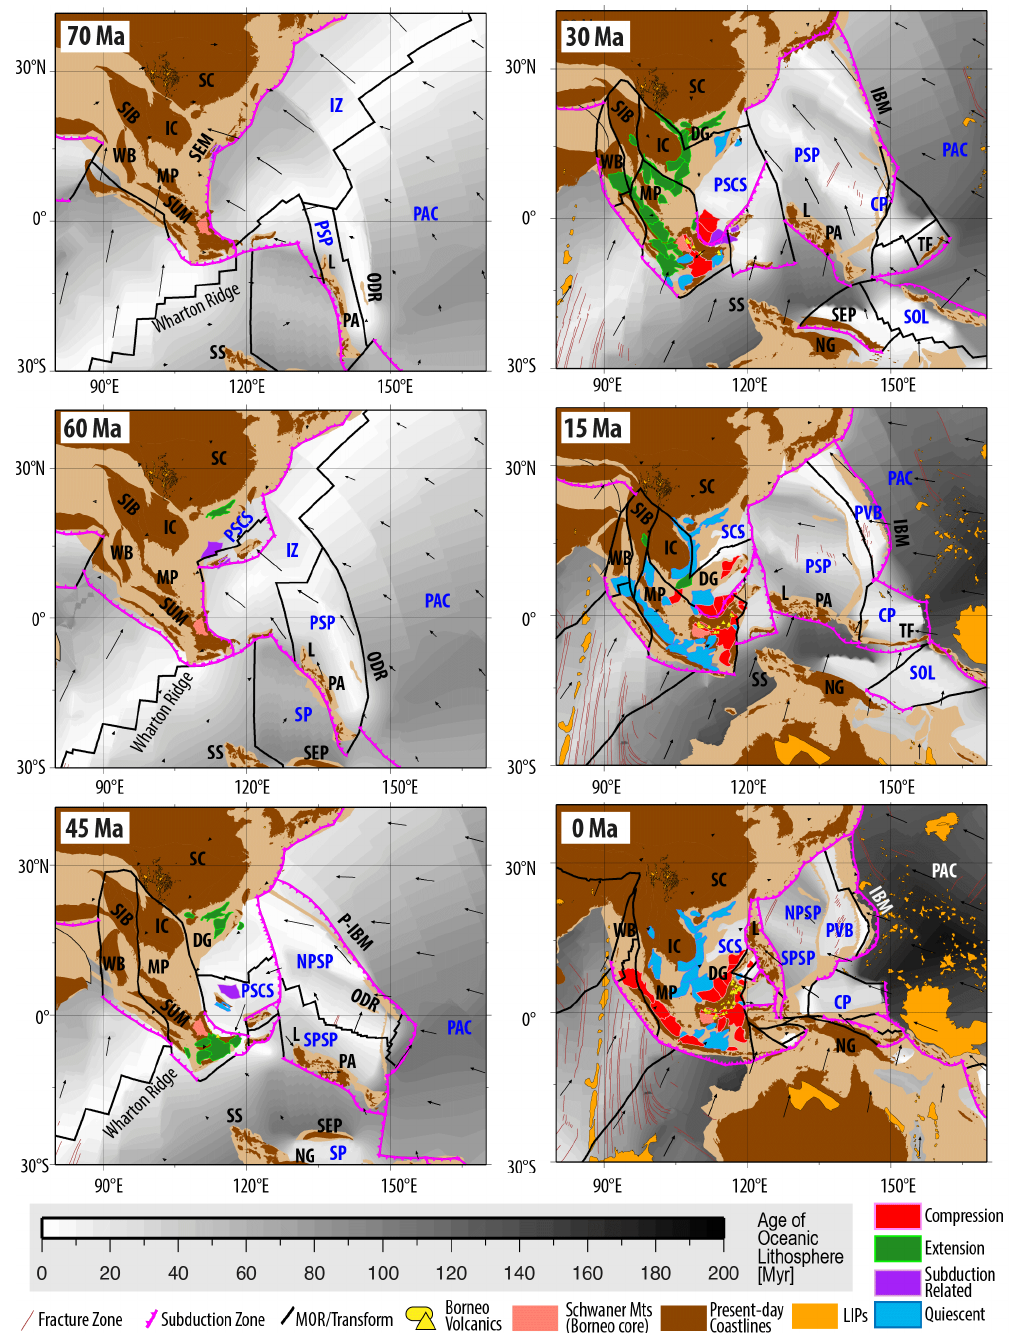
Fig. 13b. Regional reconstructions are plotted with seafloor age, continental extents, reconstructed present-day coastlines, LIPs, plate boundaries, velocities, age-coded basins and Borneo volcanics from Soeria-Atmadja et al. (1999). The proto-Izu–Bonin–Mariana (P-IBM) west-dipping subduction initiates by 55Ma following a conversion of a transform to a convergent plate boundary to consume Pacific (PAC) crust. The proto-South China Sea (PSCS) opens as a back-arc basin from 65Ma, with seafloor spreading initiating by 59Ma that detaches the Semitau (SEM) and South Palawan blocks from mainland South China (SC). These blocks collide in the mid-Eocene with northern Borneo, resulting in the Sarawak Orogeny and cessation of north-west-dipping subduction of Izanagi (IZ) crust in this region. Subduction re-initiates at a south-dipping convergent margin along northern Borneo by ∼ 40Ma to result in slab pull driving the rifting and opening of the South China Sea (SCS) from 37Ma, with seafloor spreading initiating by 32Ma and detaching the Luconia–Dangerous Grounds–North Palawan blocks (DG) from South China. Continued subduction transfers these blocks to northern Borneo and South Palawan, resulting in suturing, ophiolite obduction and the Sabah Orogeny by ∼ 15Ma. Borneo rotates counterclockwise by ∼ 80 ◦ since 50Ma, of which 50 ◦ CCW motion relative to Sumatra between ∼ 25 and 10Ma. Basins were age-coded from Doust and Sumner (2007) and color-coded by their dominant tectonic regime, and indicate extension occurred in the Makassar Straits between ∼ 55 and 35Ma, while the Java Sea basins largely experience extension between 35 and 25Ma, followed by a period of quiescence and tectonic inversion (compression) from ∼ 15Ma.TheconvergenceoftheAustralian–Pacific–SundaplatesatpresentdayhasresultedinlargelycompressionalregimesparalleltotheJava–SundaandPalawantrenches, along with the basin inversion experienced in the Makassar Straits resulting from the collision of the Sula Spur (SS) with Sundaland. SIB–Sibumasu, IC–Indochina, MP–Malay Peninsula, SS–Sula Spur, SP–Sepik Plate, SEP–Sepik composite terrane, NG–New Guinea, ODR–Oki-Daito Ridge, PVB–Parece Vela Basin. All other label descriptions are found in Fig. 12b. High-resolution animations are included in the Supplement (Mercator projection with 125 ◦ E standard parallel).